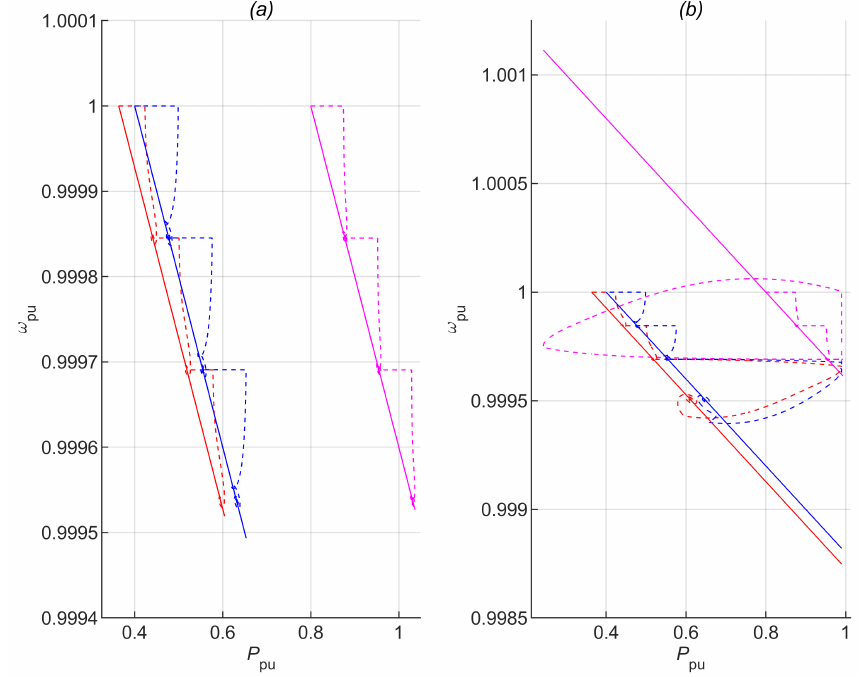
Figure 6. P − ω Droop Relation ( a ) no Jacobian, Conventional, ( b ) with Jacobian, Conventional; for VSIs at Buses (1—red, 2—magenta, 3—blue).